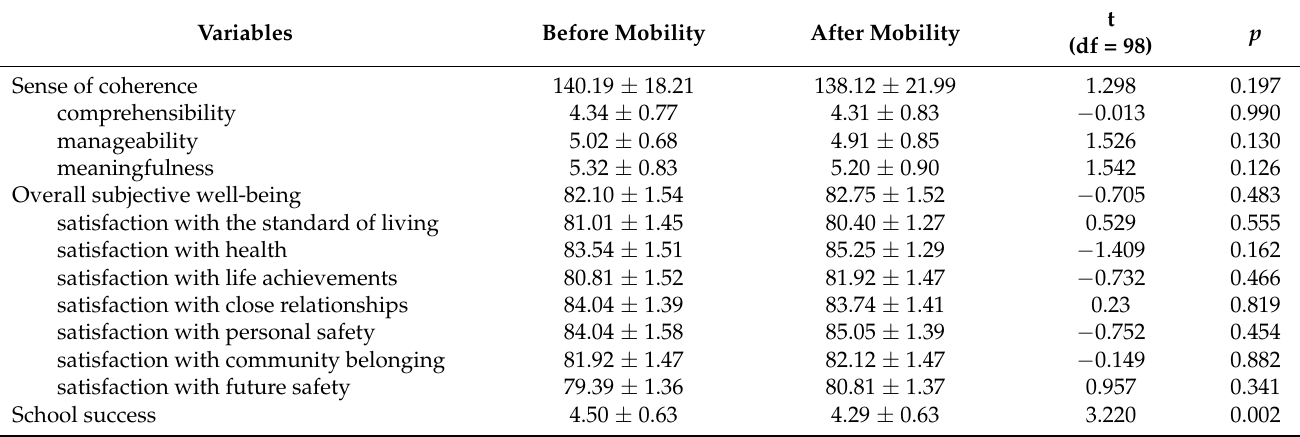
Table 2. Participants’ sense of coherence, subjective well-being, and school success ( n = 99). Variables